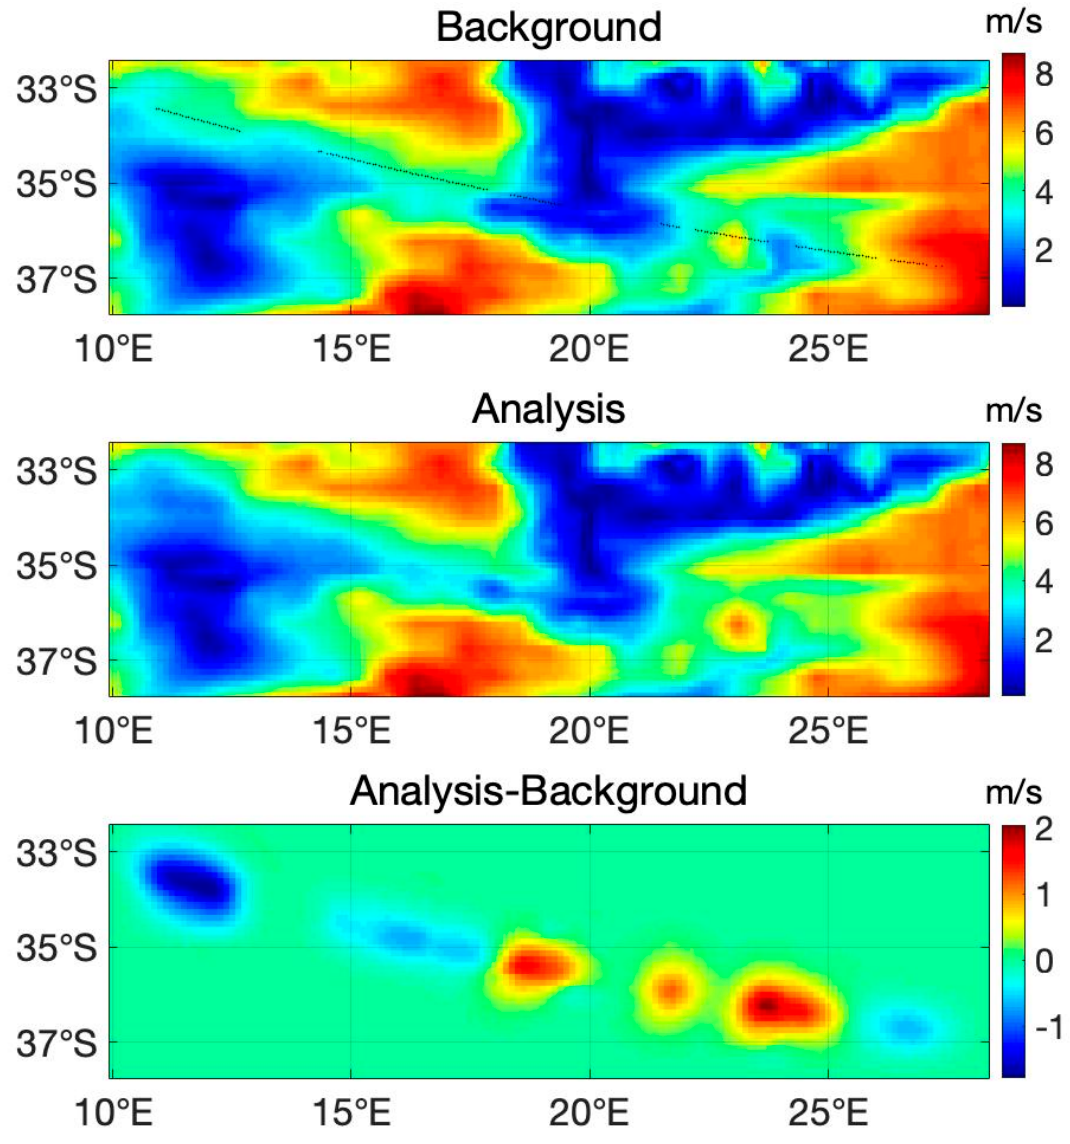
Figure 9. Assimilating CYGNSS DDMs into ECMWF background winds to improve surface wind forecasts: [ top ] demon- strating the ECMWF background at 150 km resolution, [middle] analysis field with the DDM assimilation, and [ bottom ] the difference between the two. Image by F. Huang et al.